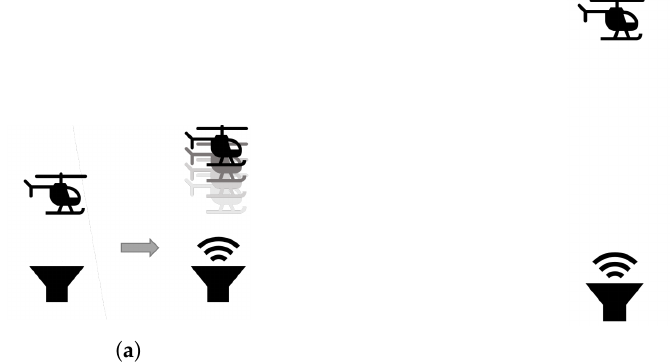
Figure 11. Two scenarios for attacks on a drone: ( a ) The drone hovers at a fixed distance from the ground when the attacker is not transmitting (i.e., the attacker’s transmitter is off). When the attacker starts transmitting, the drone gradually ascends and stops at a new height according to its new perceived distance from the “virtual” ground. ( b ) The attacker is transmitting the attacking signal, while the drone is commanded to descend. The drone stops at a preconfigured height from the attacking sensor according to the perceived distance from the “virtual” ground.